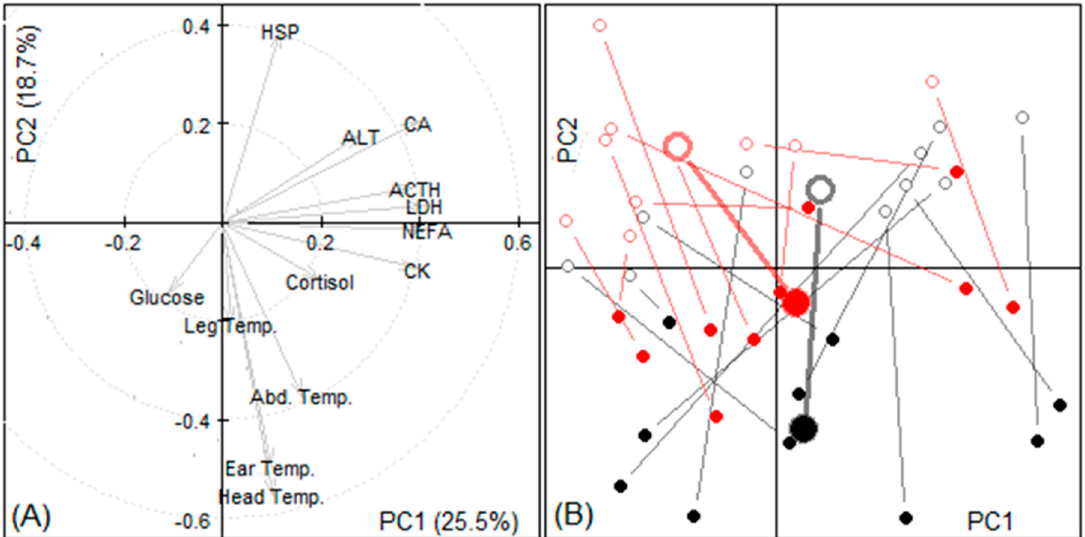
Figure 2. Principal components identified as PC1 and 2 in experiment 1. ( A ) The weights (eigenvectors) of variables in the first two principal components (PC). ( B ) Location of individual sheep samples according to their first two PC scores sorted by treatment group (black: enclosed vehicle, red: open vehicle,) and time (departure: empty circles, arrival: filled circles); samples from the same animal are joined by a line, larger circles indicate treatment groups’ means.